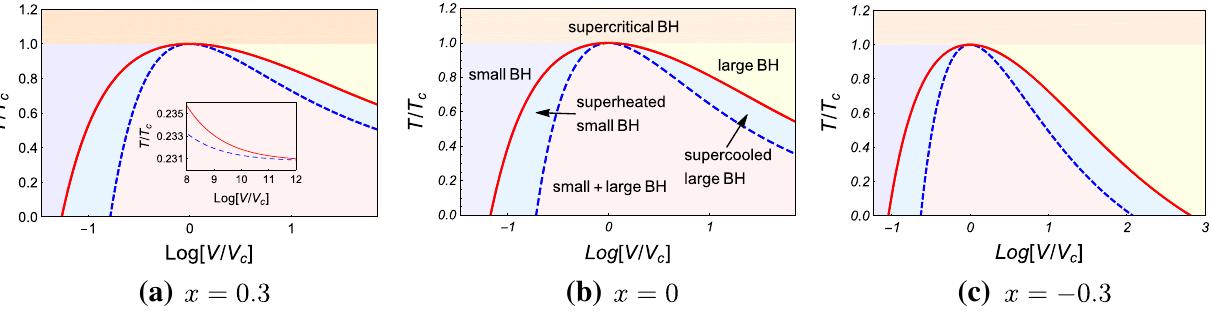
Fig. 4 Phase structure of dRGT black hole in reduced ( (cid:13) T , (cid:13) V ) space with x = 0 . 3, 0 and − 0 . 3. The solid red curve represents the coexis- tence curve of the small/large black hole, and the blue dashed curve represents the spinodal curve. The regions marked as orange, purple,